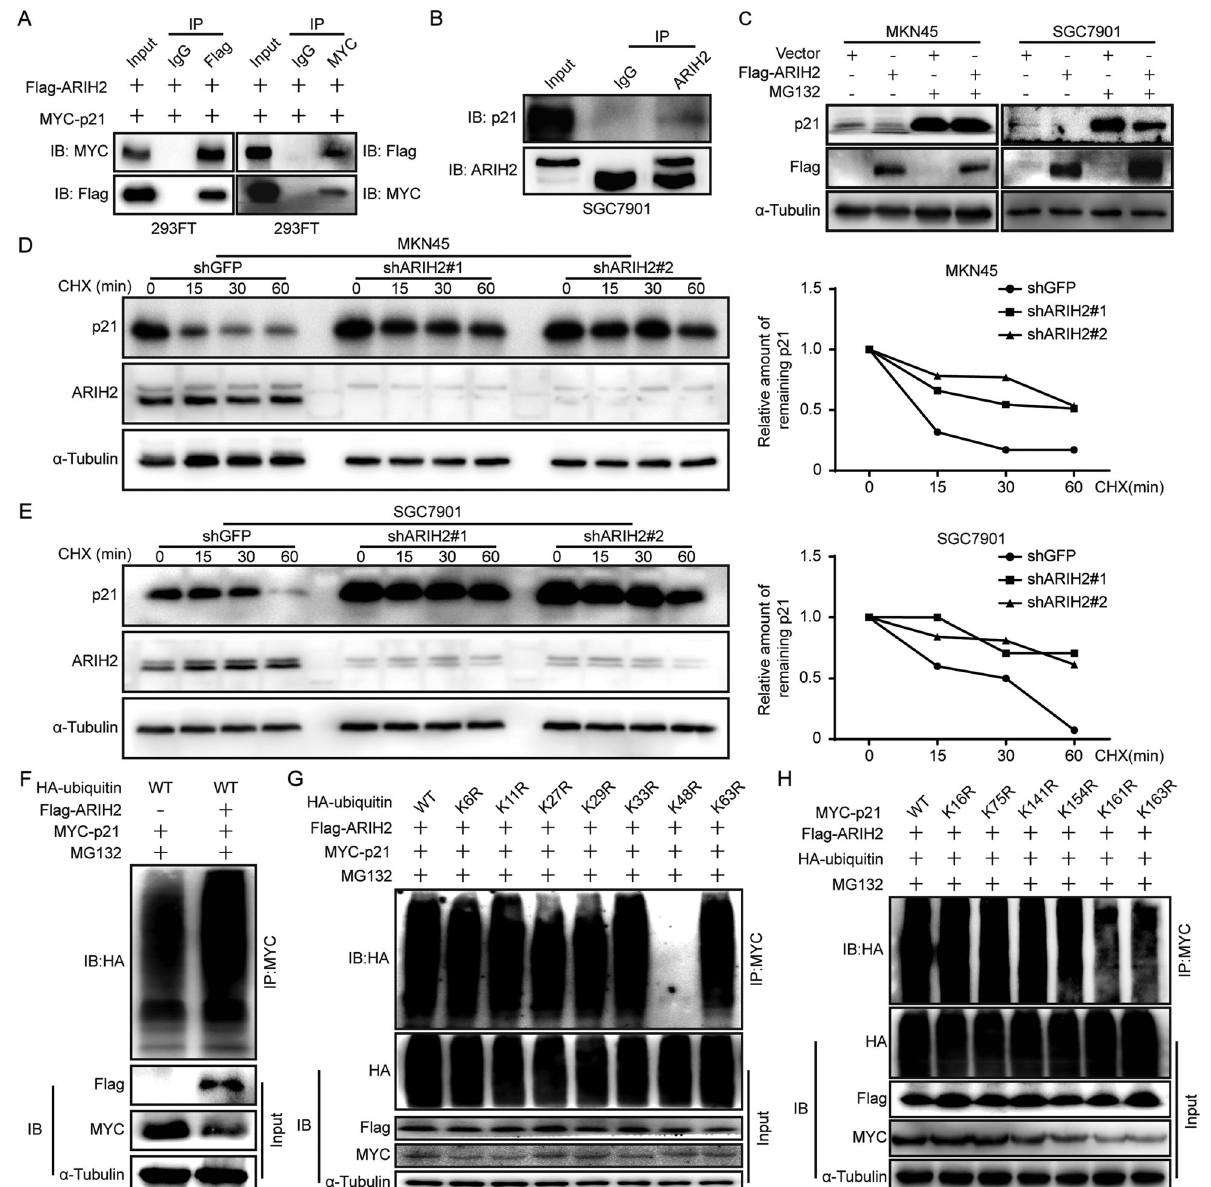
MYC antibodies, respectively. Then, anti-MYC and anti-Flag antibodies were used to detect the immunoprecipitates, and anti-Flag and anti- MYC antibodies were used to test the success of the experiment. B SGC7901 cell lysates were subjected to immunoprecipitation with control IgG and ARIH2 antibodies. The immunoprecipitate was then probed with p21 antibody, and the ARIH2 antibody was used to detect the success of the experiment. C Cell lysates were prepared from the control and ARIH2-overexpressing GC cells that had been treated with MG132 for 6 h. Equal amounts of cell lysates were immunoblotted with the indicated antibodies. D , E The control and ARIH2-knockdown GC cells were treated with CHX (100 μ g/ml) for the indicated times. Cell lysates were immunoblotted with the indicated antibodies. Quanti fi cation of the turnover of p21 in the control and ARIH2-knockdown GC cells. F Flag-ARIH2, MYC-p21 and HA-ubiquitin plasmids were transiently transfected into 293FT cells for 2 d, and the transfected 293FT cells were treated with MG132 for 7 h before proteins were harvested. The ubiquitinated p21 proteins were pulled down with an anti-MYC antibody and immunoblotted with an anti-HA antibody. G HA-ubiquitin mutants in which only one lysine residue was mutated to an arginine residue, as shown, were used, and co-IP was performed. H MYC-p21 mutants in which only one lysine residue was mutated to an arginine residue, as shown, were used, and co-IP was